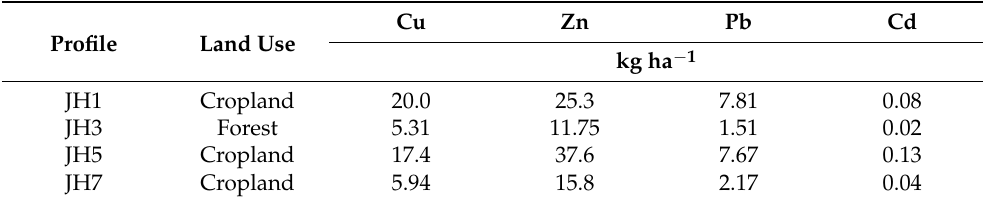
Table 4. Accumulation amounts of heavy metals for different land uses with a distance of 50 m from Jinghu expressway.